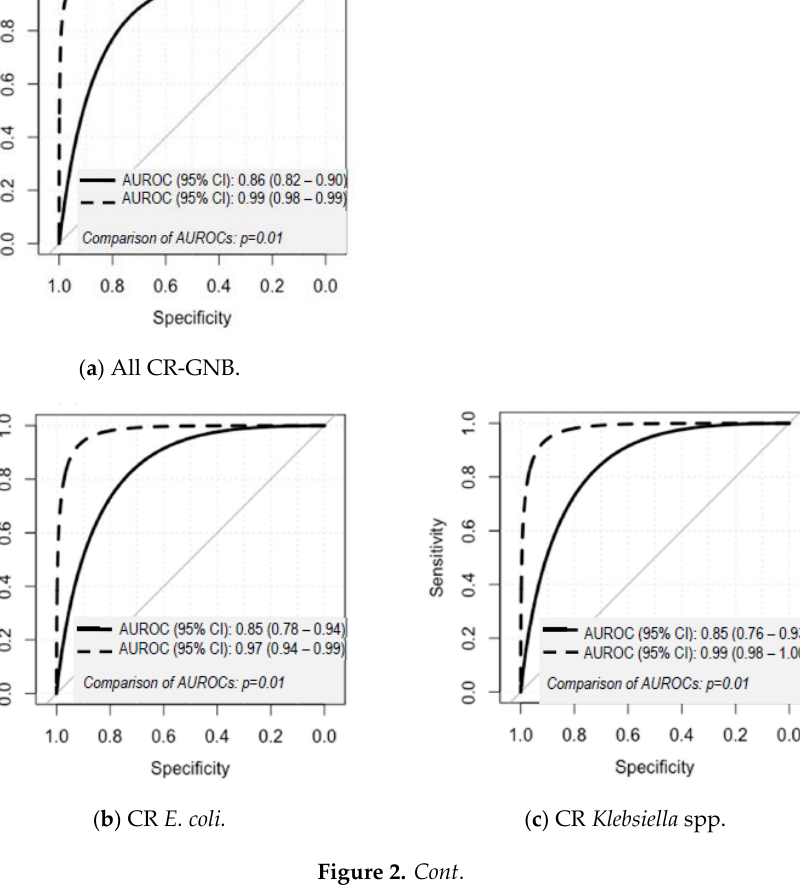
Figure 2. Receiver operating curves (ROC) plots for distinguishing between inhibitory and non-inhibitory activity at di ff erent timepoints for ( a ) All CR-GNB, ( b ) CR E. coli , ( c ) CR Klebsiella spp., ( d ) CR A. baumannii , and ( e ) CR P. aeruginosa with and without apyrase (2 U / mL) in 24 h time–kill studies (TKSs).